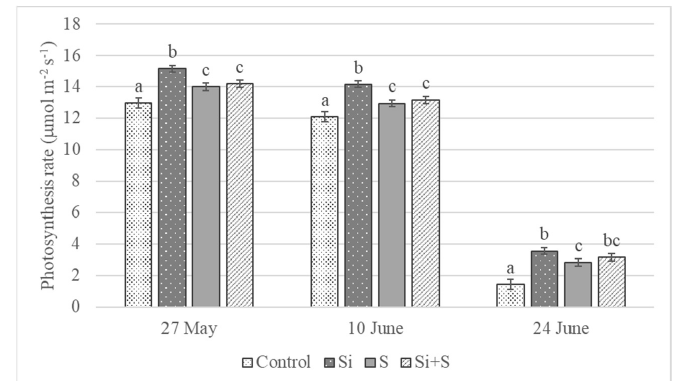
Figure 4. Assimilation rate of winter oat, (Debrecen, 2021), mean ± SE of three replicates. Different lower-case letters (a–c) mean significant difference at p < 0.05 among the treatments. When the letters on the different treatments are the same, it means there is no significant difference between them.